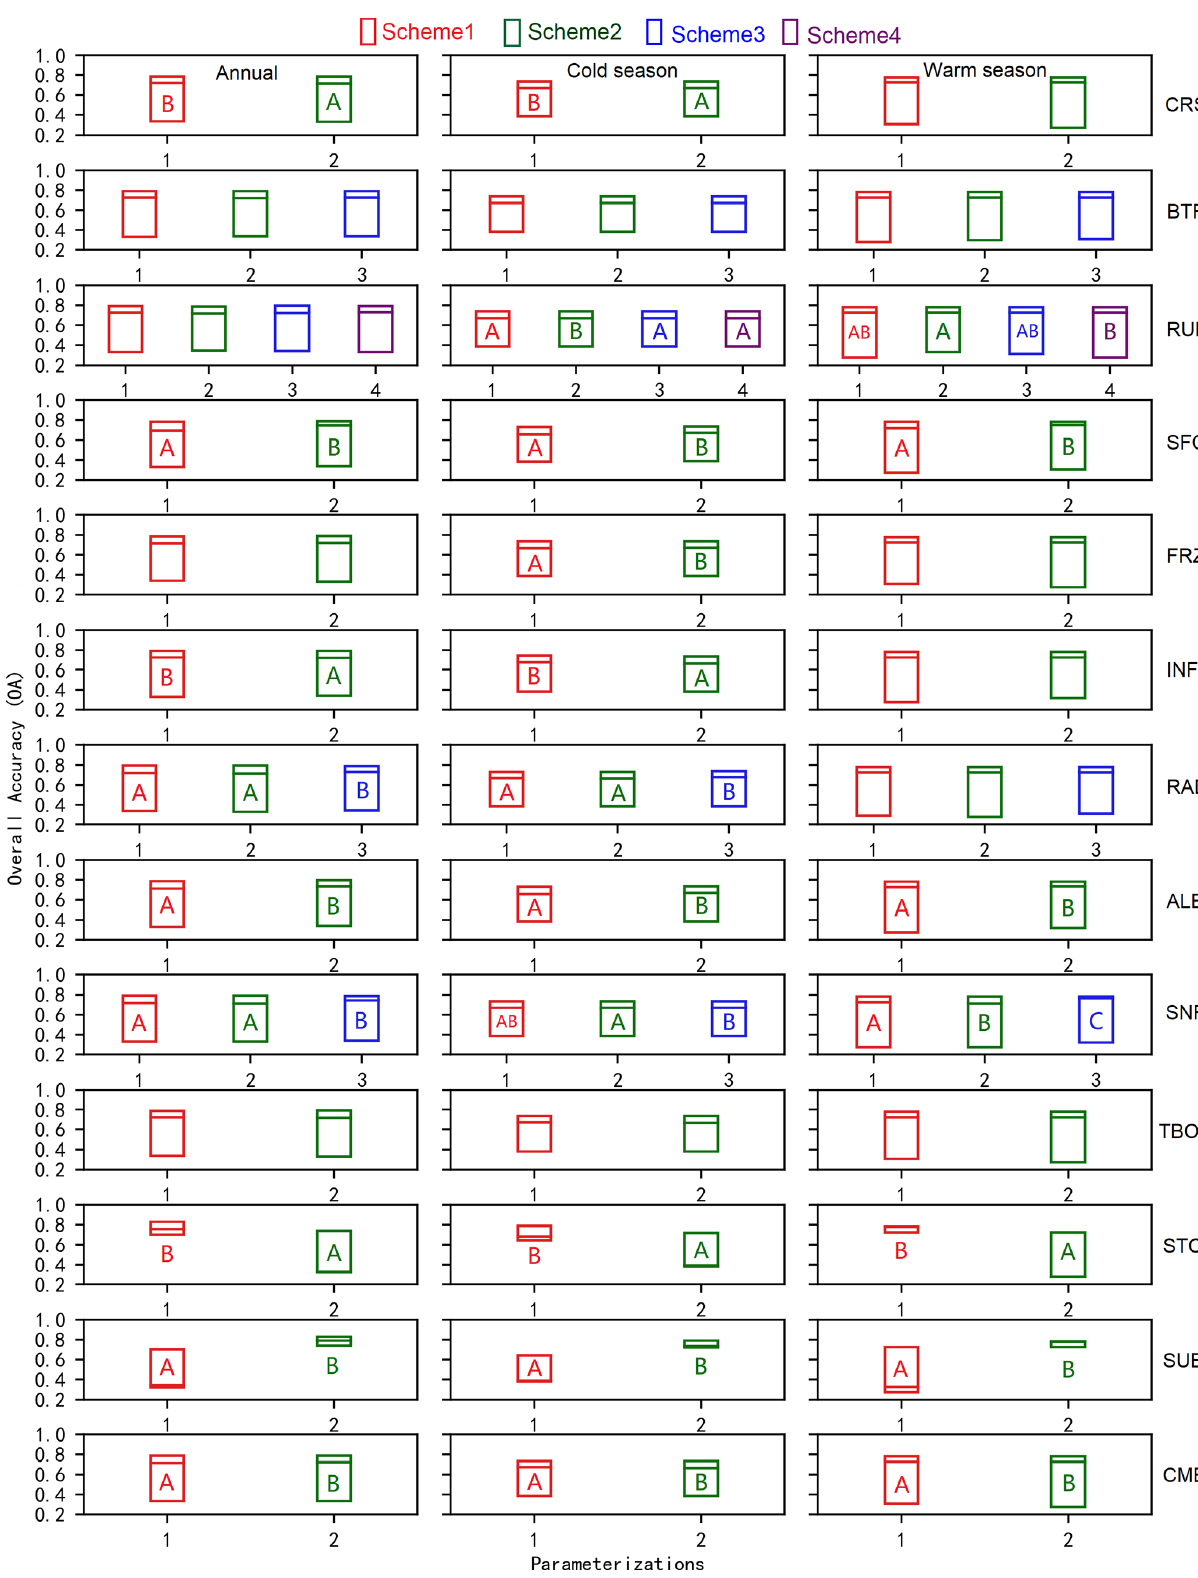
Figure 6. Distinction level for overall accuracy (OA) of snow cover events (SCEs) annually and during the warm and cold seasons at the TGL site. The limits of the boxes represent the upper and lower quartiles, and the lines in the boxes indicate the median